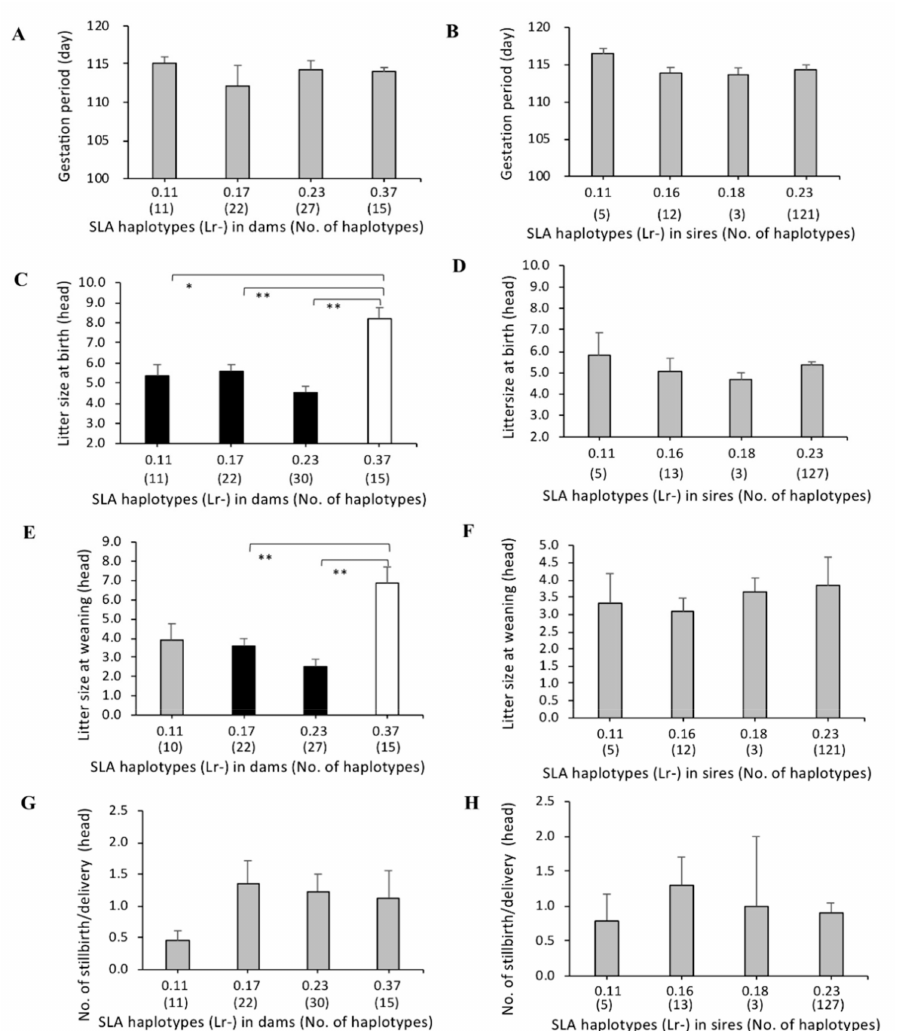
Figure 4. Comparison of reproductive performances among SLA class II homozygous haplotypes in MMPs. Haplotypes and number of deliveries for each haplotype are shown along the X -axis, and the bars for each homozygous haplotype show the mean values and whiskers (standard errors) of gestation periods in dams ( A ) and sire ( B ), litter sizes at birth in dams ( C ) and sires ( D ), litter sizes at weaning in dams ( E ) and sires ( F ), and the number of stillbirths / delivery in dams ( G ) and sires ( H ) along the Y -axis. Black and white bars represent lower and higher haplotypes, respectively, and mean values of each trait with significant di ff erences among haplotypes. Gray bars represent the mean values of haplotypes without any significant di ff erences among the haplotypes. The probabilities of significant di ff erences among haplotypes are indicated by single ( p < 0.05) and double ( p < 0.01)